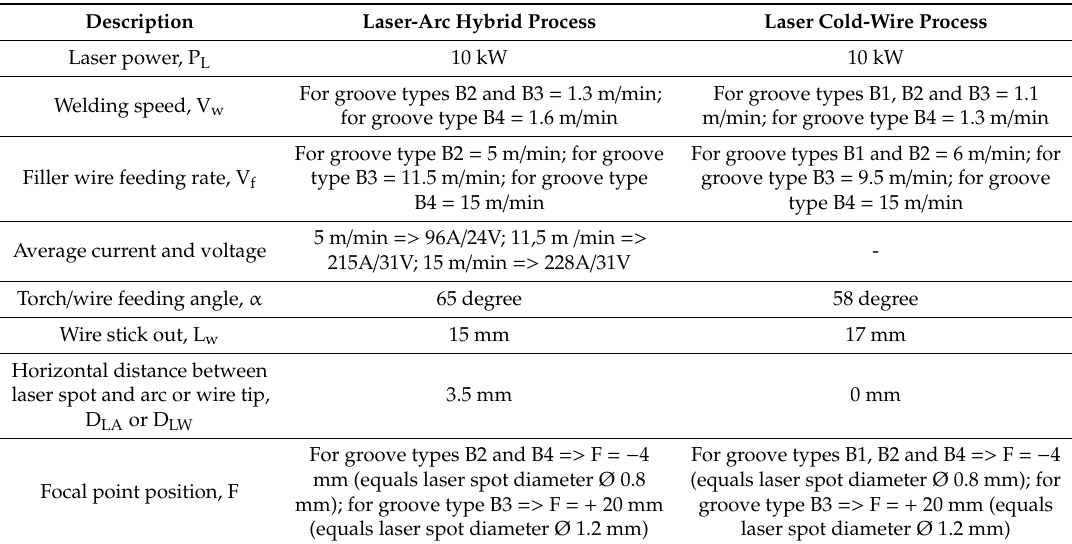
Table 2. Welding parameters in the laser-arc hybrid and laser cold-wire welding experiments. Description Laser-Arc Hybrid Process Laser Cold-Wire Process Laser power, P L 10 kW 10 kW Welding speed, V